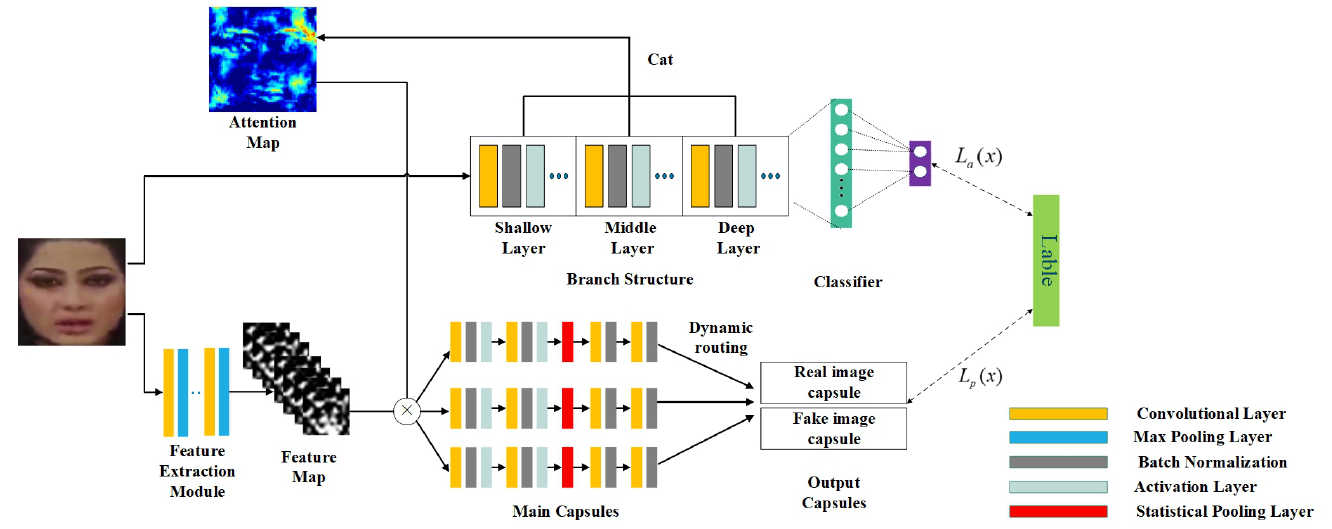
Figure 2. Network